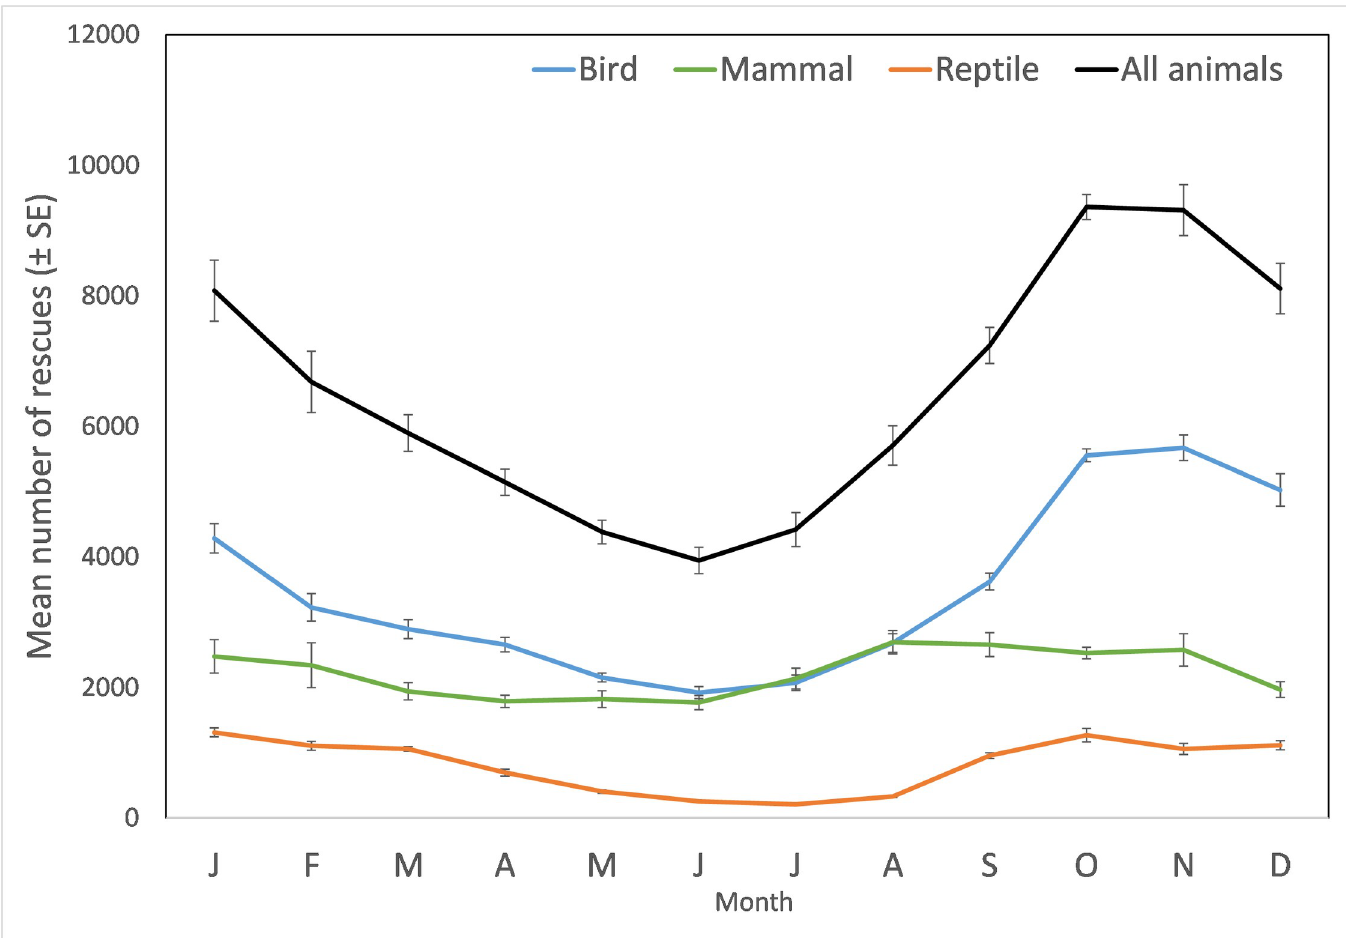
Fig 5. Mean ± SE number of rescues per month pooled for all years, for each animal group and all animals combined.